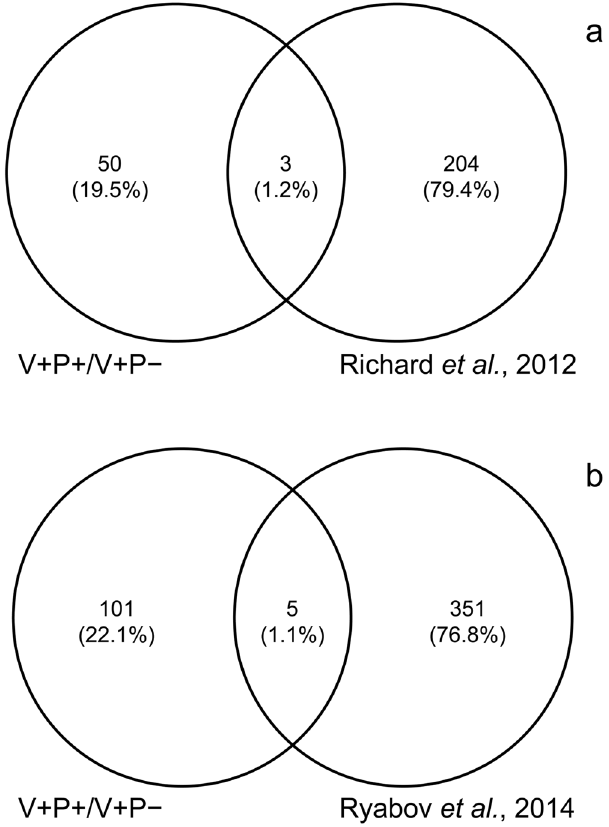
Figure 5. Genes in common between the DEG list corresponding to Varroa infested bees fed with the two different diets and the list of “cuticle integrity” genes obtained from Richard and colleagues’ study 24 ( a ) or the list of genes related to canonical immunity pathways obtained from Ryabov and colleagues’ study 21 ( b